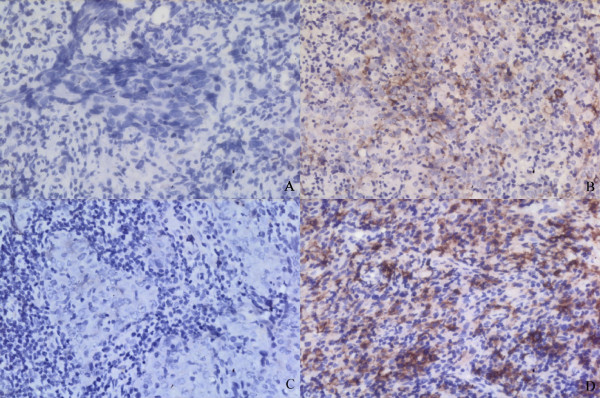
Immunohistochemical staining for (A) CD 80- and (B) CD80 (+1) in undifferentiated carcinoma of the nasopharynx (×400); (C) CD 86- in non-keratinizing squamous cell and (D) CD86 (+2) in undifferentiated carcinoma of the nasopharynx (×400).